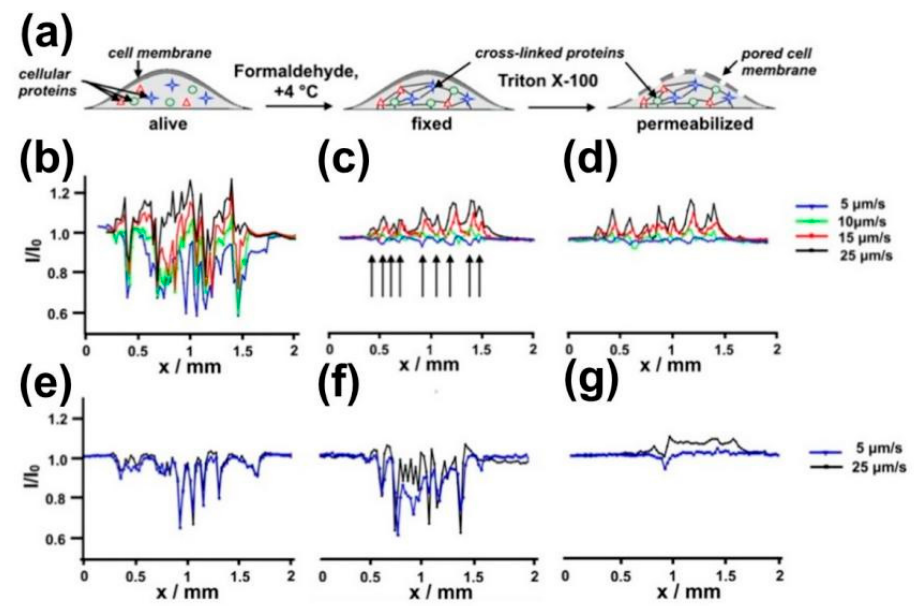
Figure 12. ( a ) Schematic representation of alive, fixed, and permeabilized cell. Influence of the UME translation speed on the SECM response (normalized current) provided by alive ( b , e ), fixed ( c , f ), and permeabilized ( d , g ) adherent WM-115 melanoma cells in the presence of noncharged (FcCH 2 OH, ( b – d )) and charged (FcCOOH, ( e – g )) redox mediators. Copyright (2016) American Chemical Society.